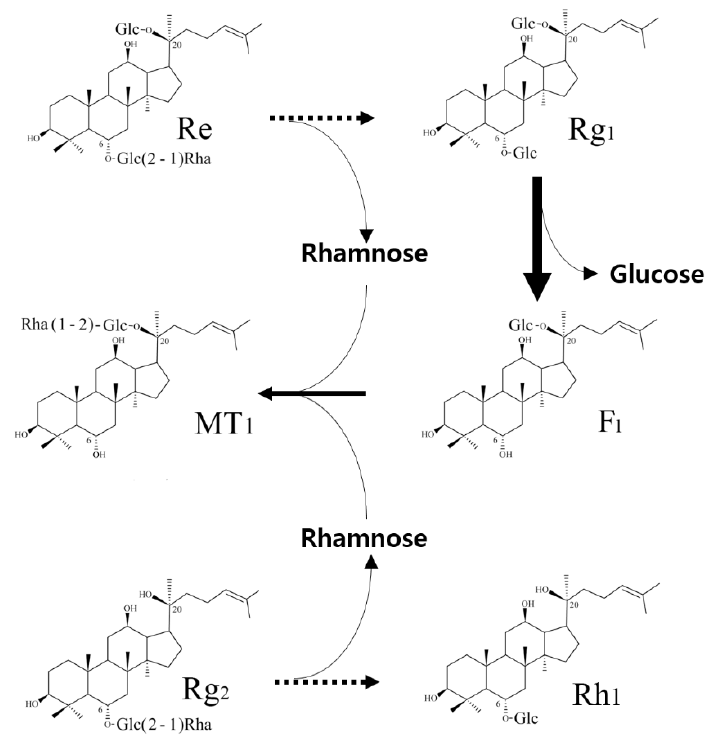
Figure 6. Conversion pathways of ginsenosides Re and Rg 2 (S) by MT619.